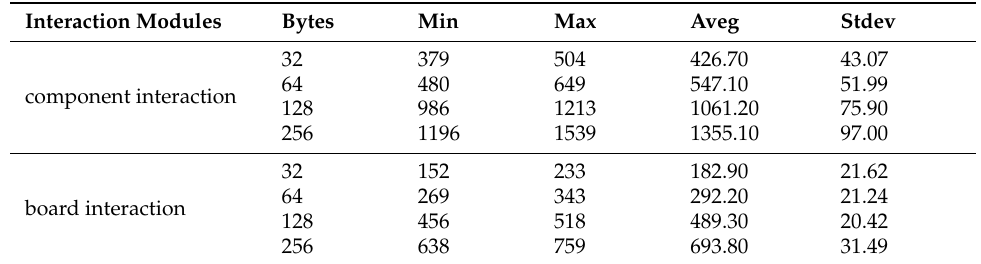
Figure 13. The communication delay tests when the size of the packet is 64 bytes and 128 bytes, re- spectively. Table 2. Performance analysis of data interaction